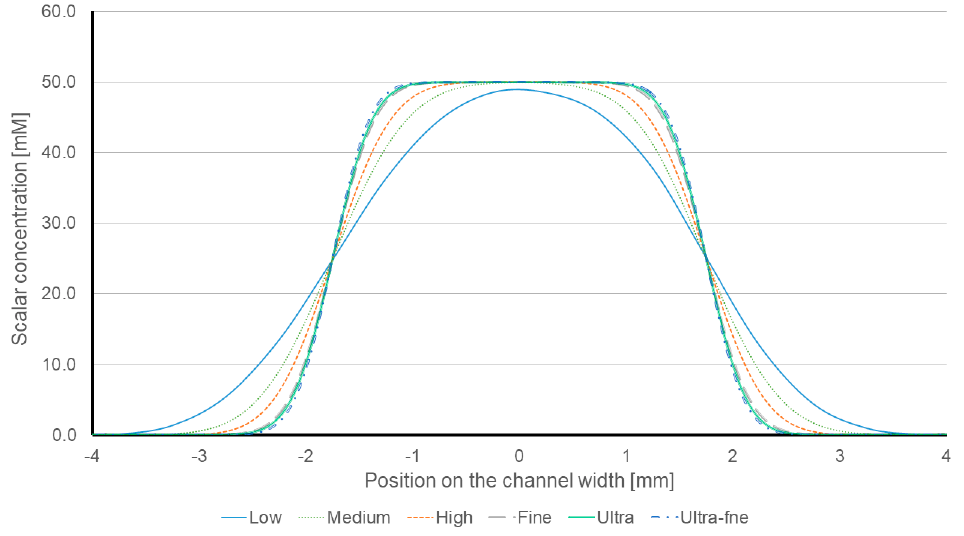
Figure A1. Distribution of scalar with respect to the mesh design in the 90-degree model.